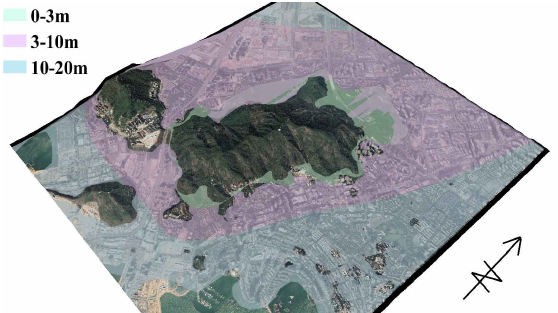
Figure 12. Distribution of sedimentary layers in the P2